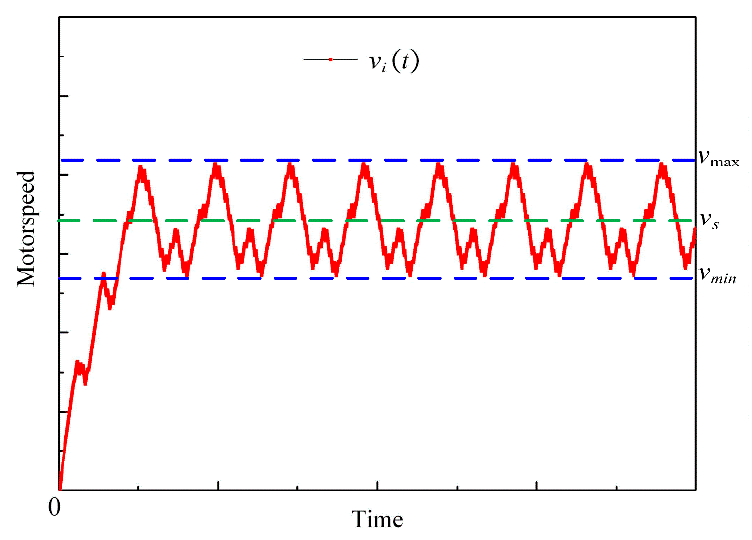
Figure 18. Schematic diagram for the instantaneous velocity of the rotor. (cid:0) (cid:1) (cid:26) Q q ( t ) + , Q q ( t ) ≥ 0 As shown in Figure 19, Q ( t ) = (cid:0) (cid:1) , and the instantaneous tan- Q q ( t ) − , Q q ( t ) < 0 gential velocity are defined as the forward velocity when the direction is to the right, and the backward velocity when the direction is to the left, in the three regions of the driving method. (cid:12) (cid:12) (cid:12) (cid:12) ( t ) − (cid:12) Q q (cid:12) , respectively, and T Qall denotes the one-cycle time of the superimposed pulse driving method. T Q + denotes the time for the stator particle to rotate in the clockwise direction within T Qall , and T Q − denotes the time for the stator particle to rotate in the counterclockwise direction within T Qall .